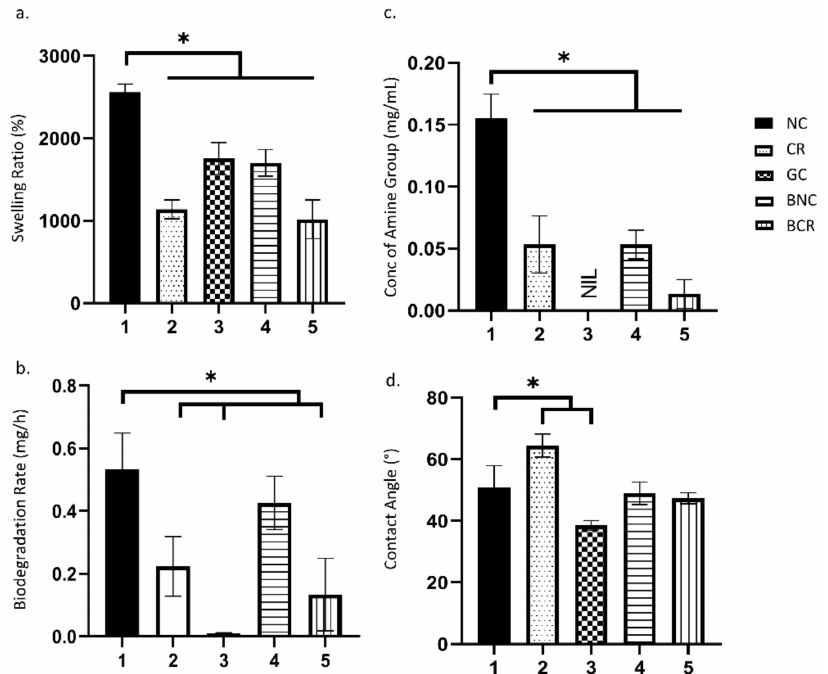
Figure 2. The physical characterisation of the scaffolds at 37 ◦ C. ( a ) the water absorption ability, ( b ) biodegradation rate, ( c ) degree of crosslinking, and ( d ) the contact angle. * p < 0.05 indicates the siginificant differences of the fabricated